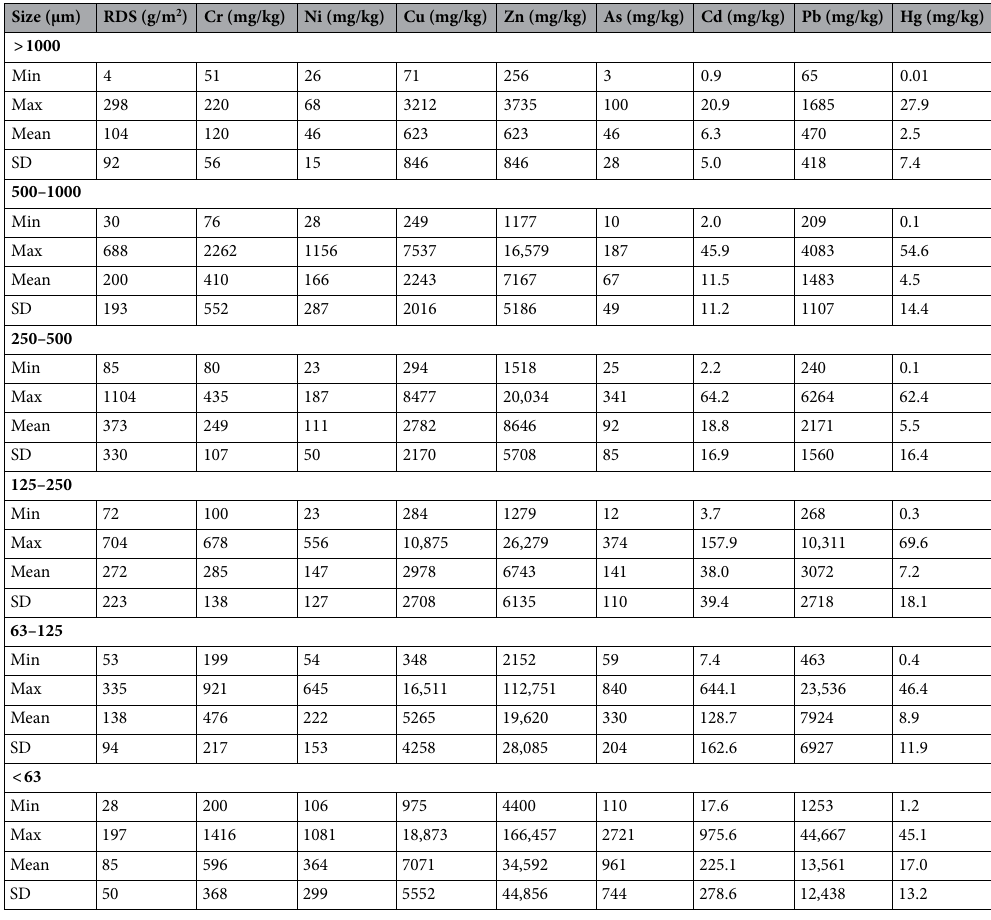
Table 1. Minimum, maximum, and mean values of PTEs in the different sizes of road deposited sediments of this